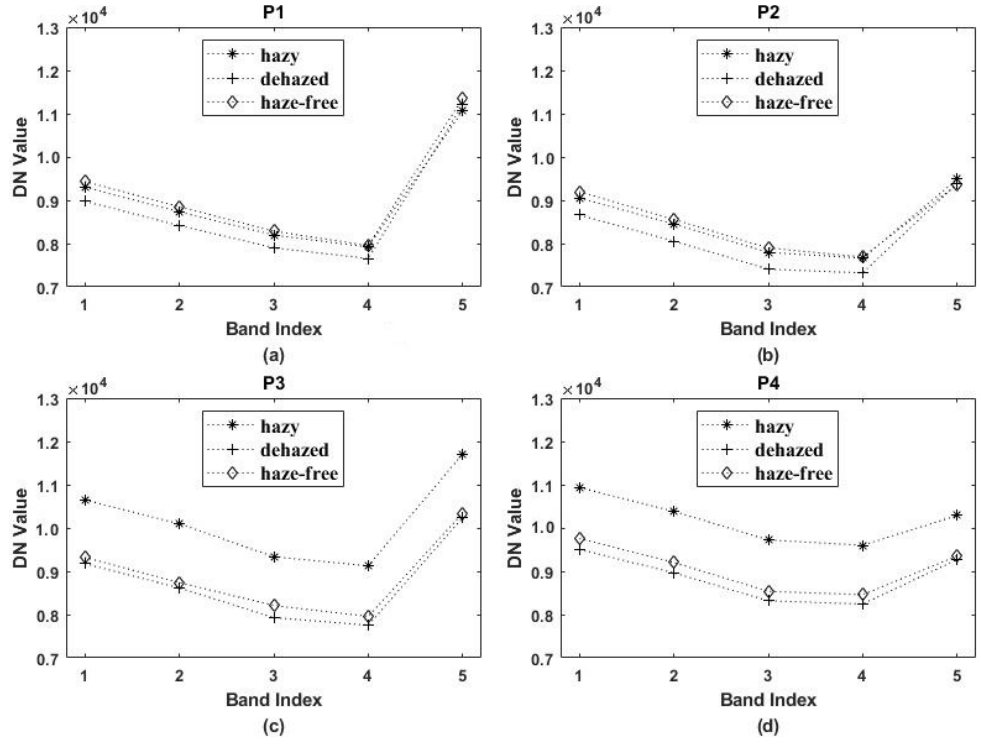
Figure 17. Spectral profiles of pixels in hazy (asterisk), dehazed (plus) and haze-free (diamond) images. The location of sampled pixels is marked by cross 1–4 in Figure 8a. ( a – d ) spectra corresponding to cross 1 to 4, respectively. The X -axis is band index and Y -axis is DN (digital numbers) value. Figure 18 presents the blue and red band profiles of hazy (red line), dehazed (green line), and haze-free (blue line) images. Along the vertical line, the hazy image is relatively clear on both sides while affected by haze in the middle. Correspondingly, the left and right parts of Figure 18a,c have